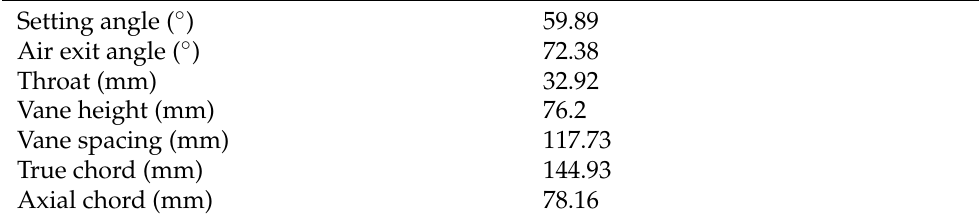
Figure 1. Schematic of the NASA C3X vane with enumerated cooling channels, as reported in the original report [11]. Table 2. Geometric parameters of C3X vane.